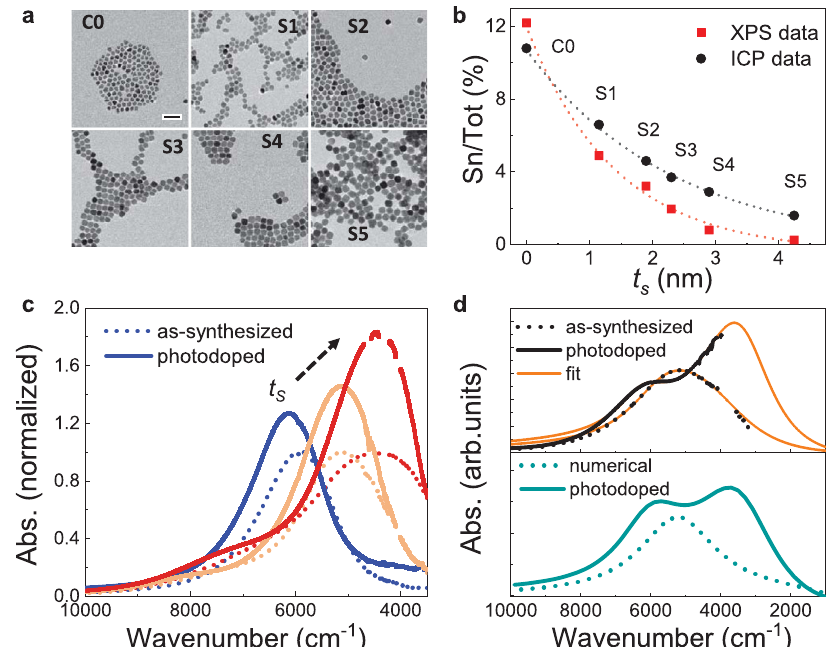
Fig. 2 ITO-In 2 O 3 core – shell colloidal nanocrystals. a TEM images of the nanocrystals at different stages of the synthesis. Starting from an aliquot of the core (C0), layers of In 2 O 3 progressively form a thicker shell around the ITO nuclei (S1 – S5). Scale bar is 50 nm for each panel. b Comparison between the Sn-dopant concentrations obtained from inductively coupled plasma mass spectrometry (ICP-OES) and X-ray Photoelectron Spectroscopy (XPS) as a function of shell thickness ( t s ). The higher Sn/Tot values of the volume sensitive ICP-OES measurements with respect to the surface sensitive XPS measurements indicate that Sn atoms remain segregated in the core of the NCs. Dashed lines are to guide the eye. c Normalized absorbance of typical ITO- In 2 O 3 core – shell samples with increasing shell size, in as-synthesized (dotted lines) and photodoped (solid lines) cases, with a t s of 0.15 nm (blue), 1.85 nm (orange), and 2.3 nm (red). Growing an undoped shell continuously redshifts the energy of the localized surface plasmon resonance (LSPR) peak in the NIR. After 20 min of UV exposure, the intensity of the LSPR peak increases signi fi cantly, reaching values up to almost double its initial absorbance. d Top panel: Absorbance of sample S5 ( t s = 4.25 nm), as-synthesized (dotted line) and photodoped (solid line). The fi tting of the experimental data using the multi-layer optical model is depicted by the orange lines. Bottom panel: Numerical simulations of the absorbance of the same ITO-In 2 O 3 NC with t s = 4.25 nm (dotted green lines) and the simulation with extra electrons (i.e., photodoping, solid green